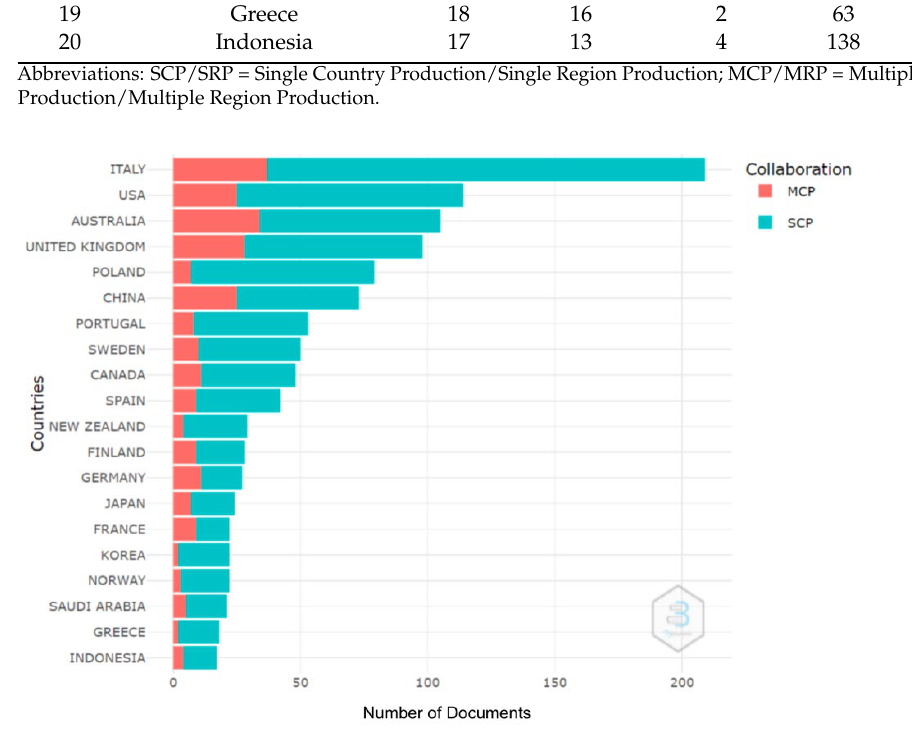
Figure 2. Most productive countries/regions.